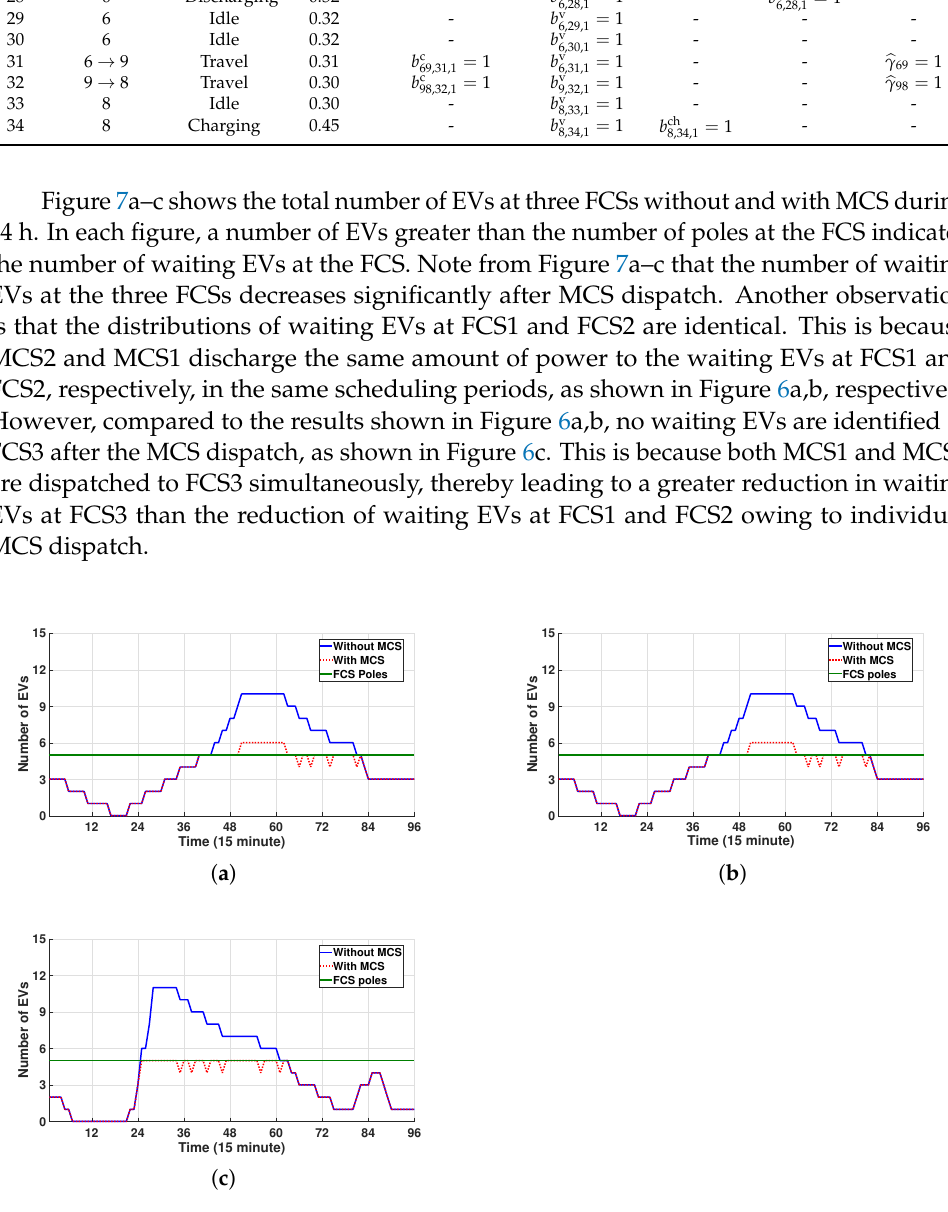
Figure 7. Comparison of the number of EVs without and with MCS between three FCSs. ( a ) FCS1. ( b ) FCS2. ( c )